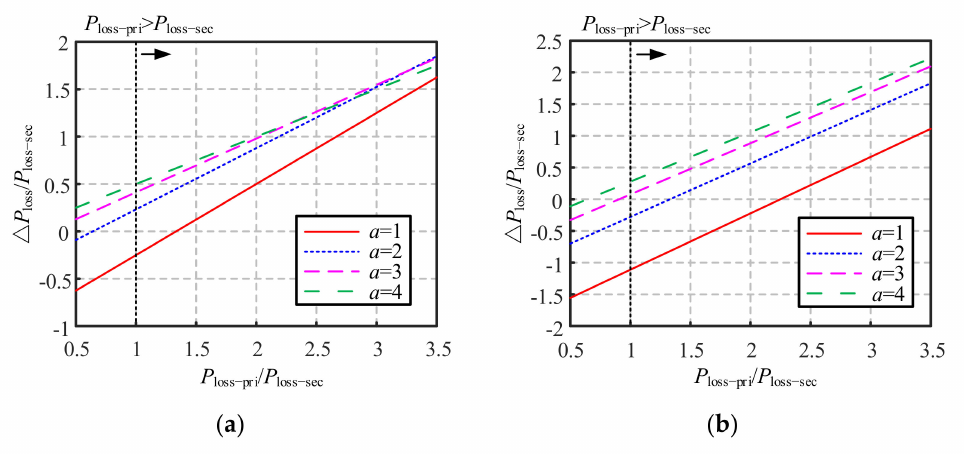
Figure 3. Relationship between loss reduction and P loss-pri and P loss-sec under different relative voltage gain G 0 . ( a ) G 0 = 2; ( b ) G 0 =